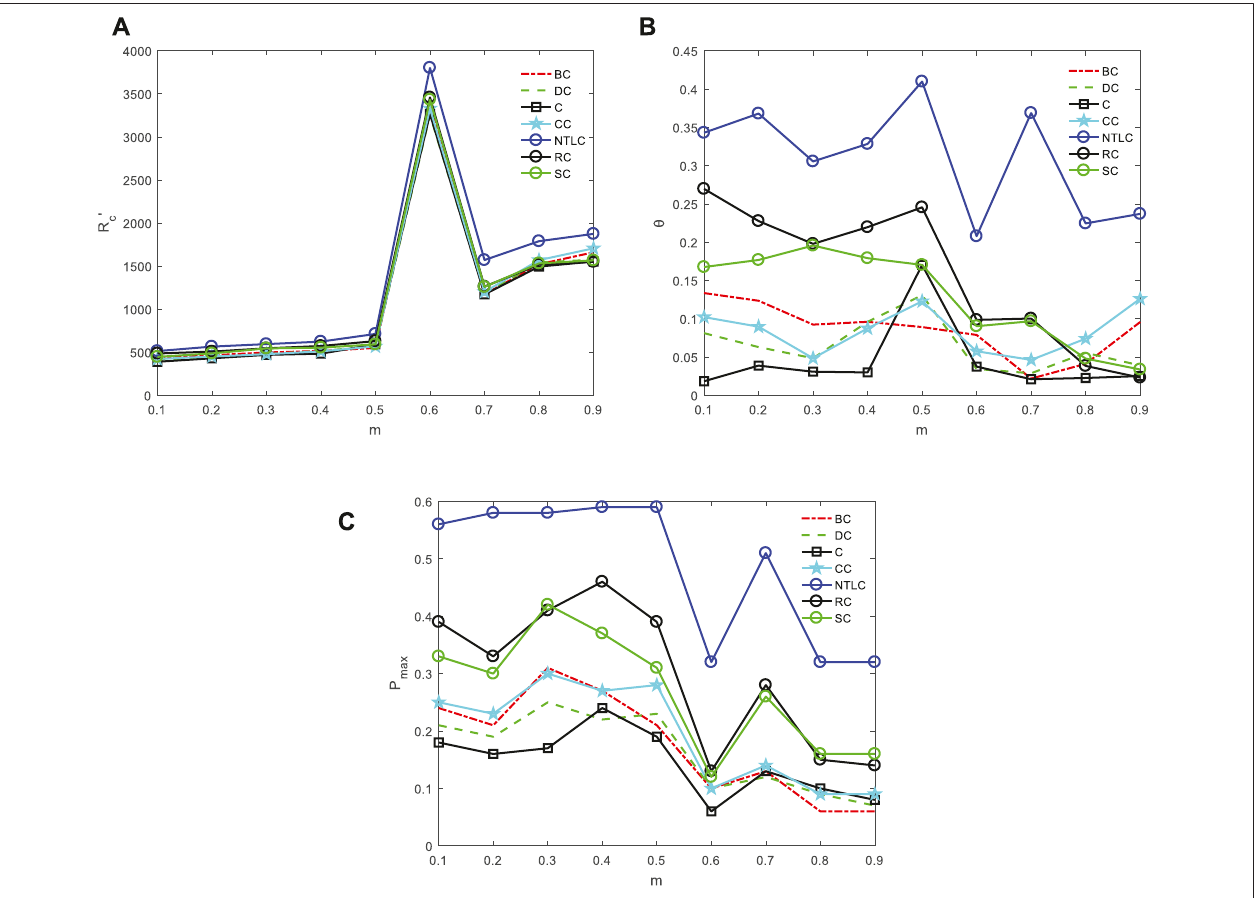
FIGURE4| Repaireffectofsevenmethodswhensomenodesinthenetworkaredeliberatelydamaged. (A) Maximumthroughputofthenetworkafterrepairing; (B) maximum throughput increasing rate of the network after repairing; (C) probability of fi nding the ground-truth best repairing node. The results are averaged over 100